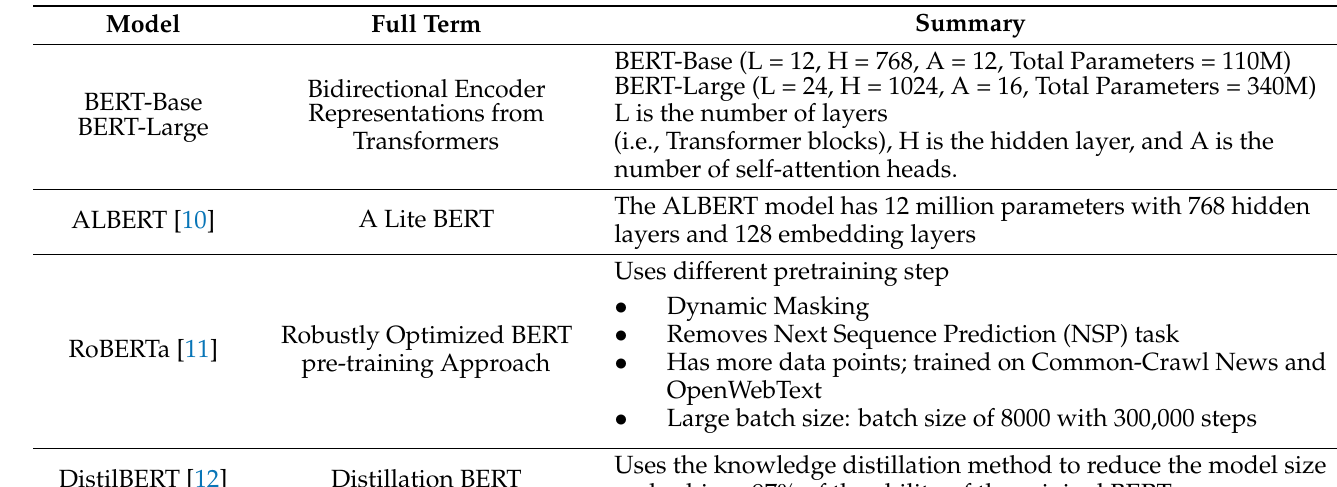
Table 1. Example of BERT model and its variants based on